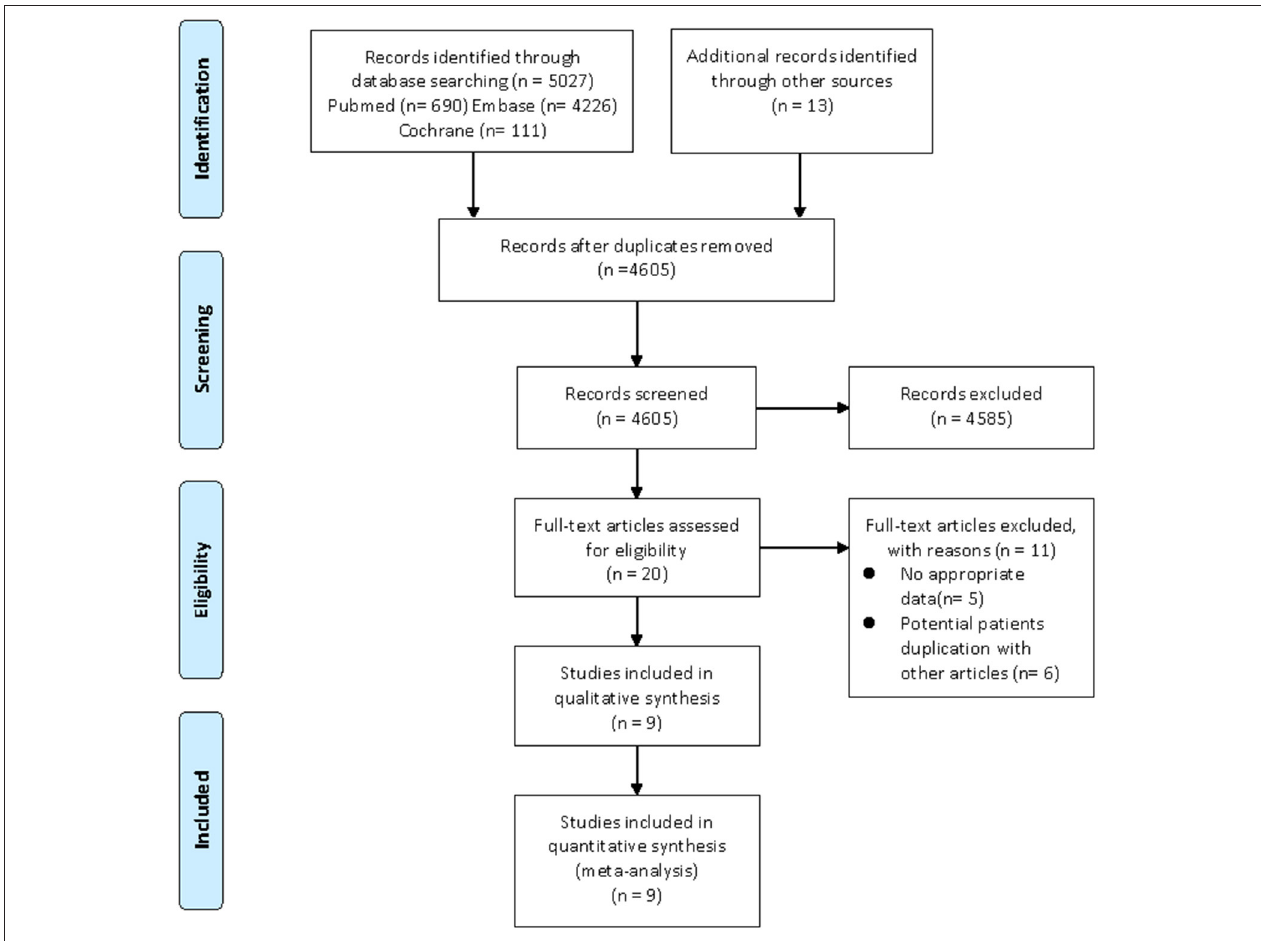
FIGURE 2 | Flow diagram of the selection process for studies on cardiovascular risk factors. From Moher et al. (20).